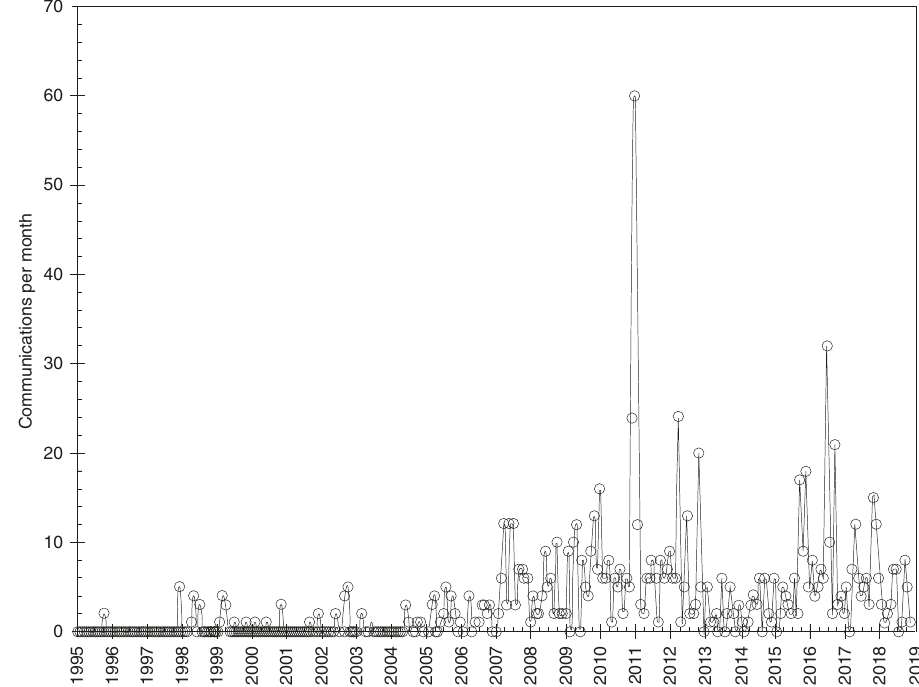
Fig. 1 Number of publications mentioning climate change per month published in the public websites of presidential of fi ces in Mexico. The period spans four federal administrations from December 1994 to November 2018; points represent the total number of communications published by presidential of fi ces mentioning climate change retrieved from the public websites per calendar